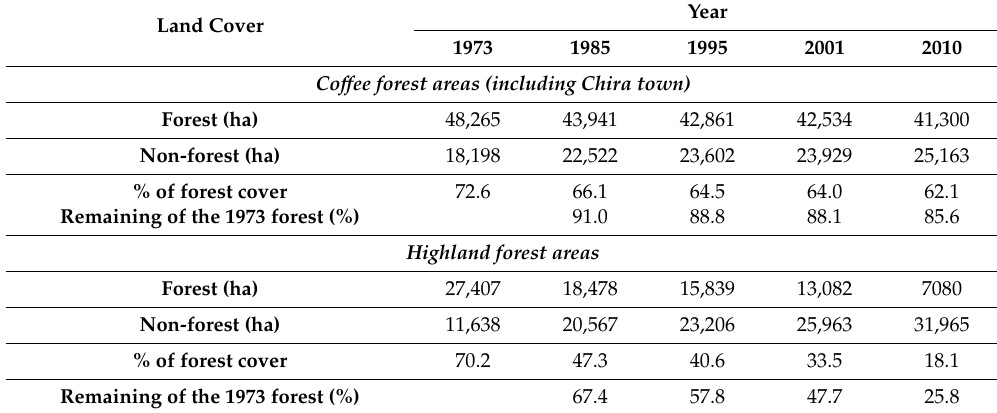
Table 1. Patterns of forest cover change in Gera from 1973 to